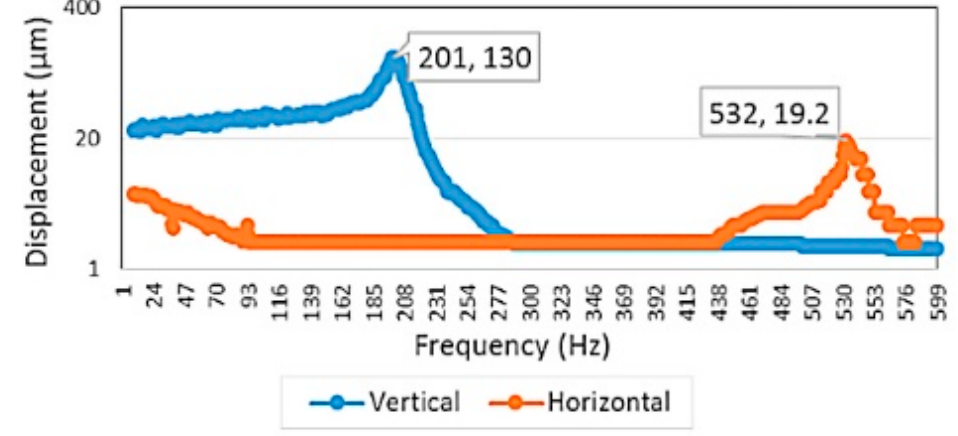
Figure 21. Waveguide mechanical frequency response. Both vertical and horizontal displacement were measured. Driving input voltages are 100 V DC applied at the bottom electrodes and + 150 V AC at the top electrodes.